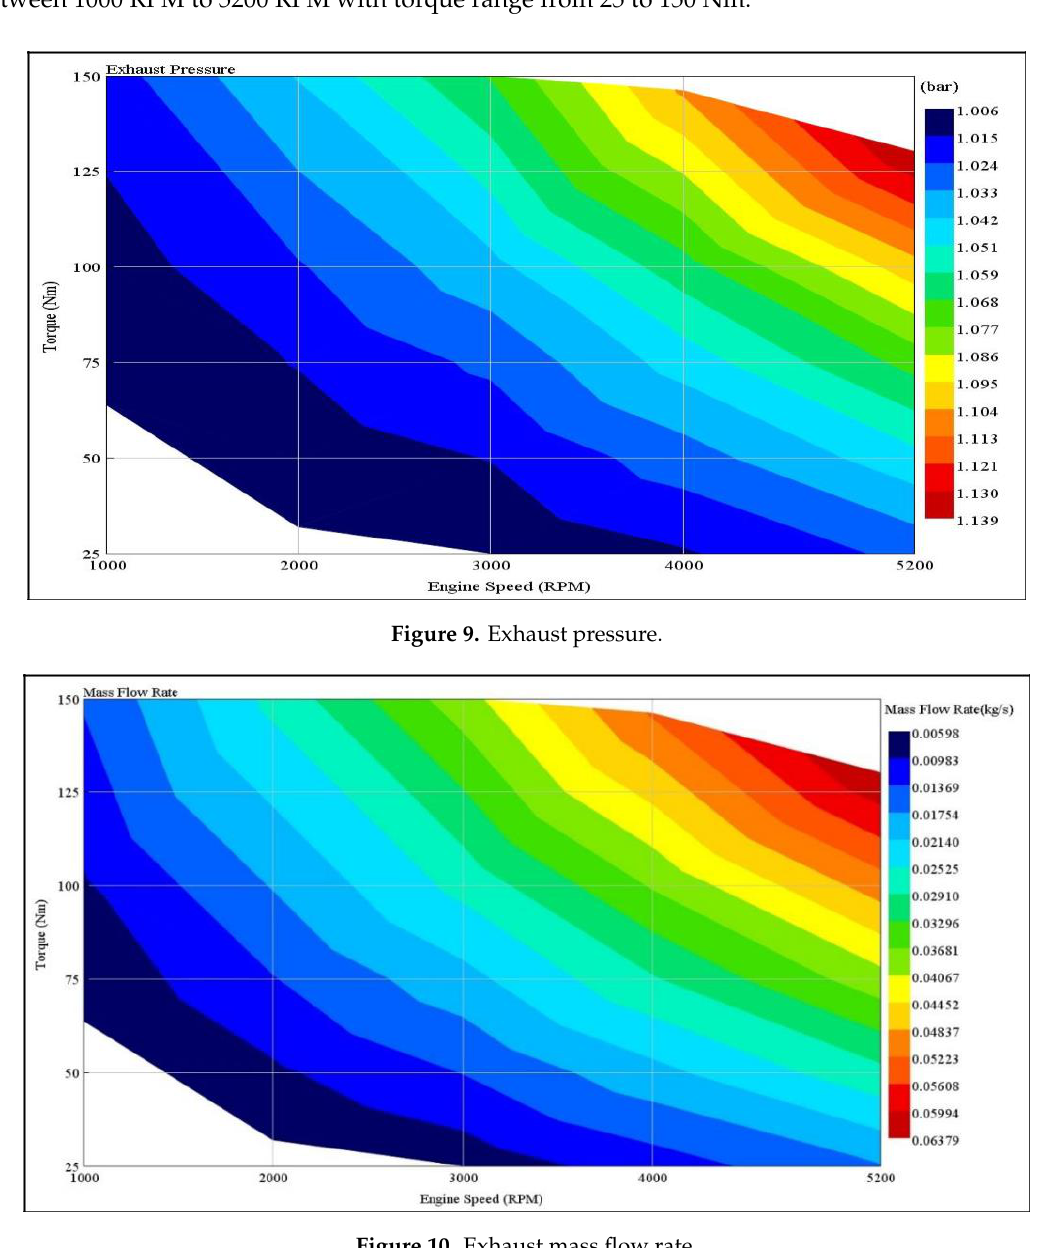
Figure 10. Exhaust mass flow rate.